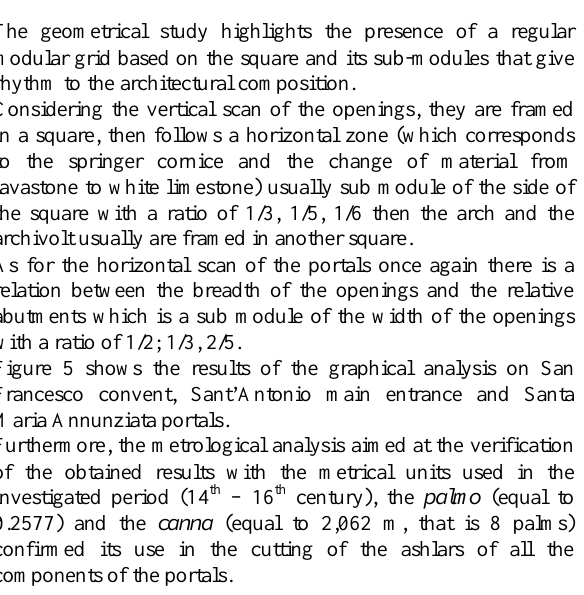
Figure 5. Graphical geometrical analysis of some studied